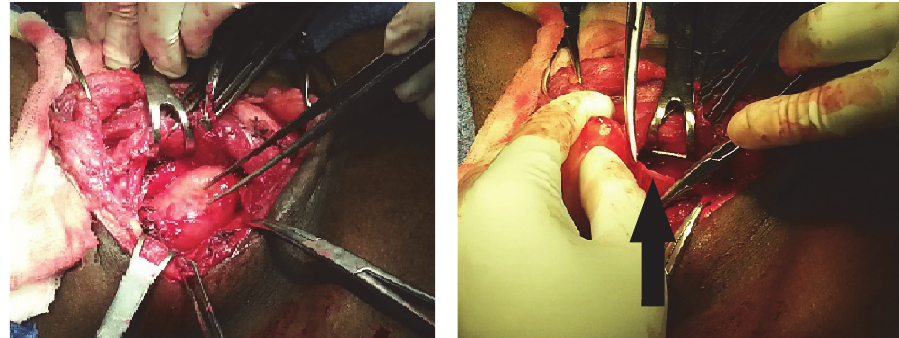
Figure 6: The rest of the lesions were also similarly resected preserving the vagus nerve (black arrow).